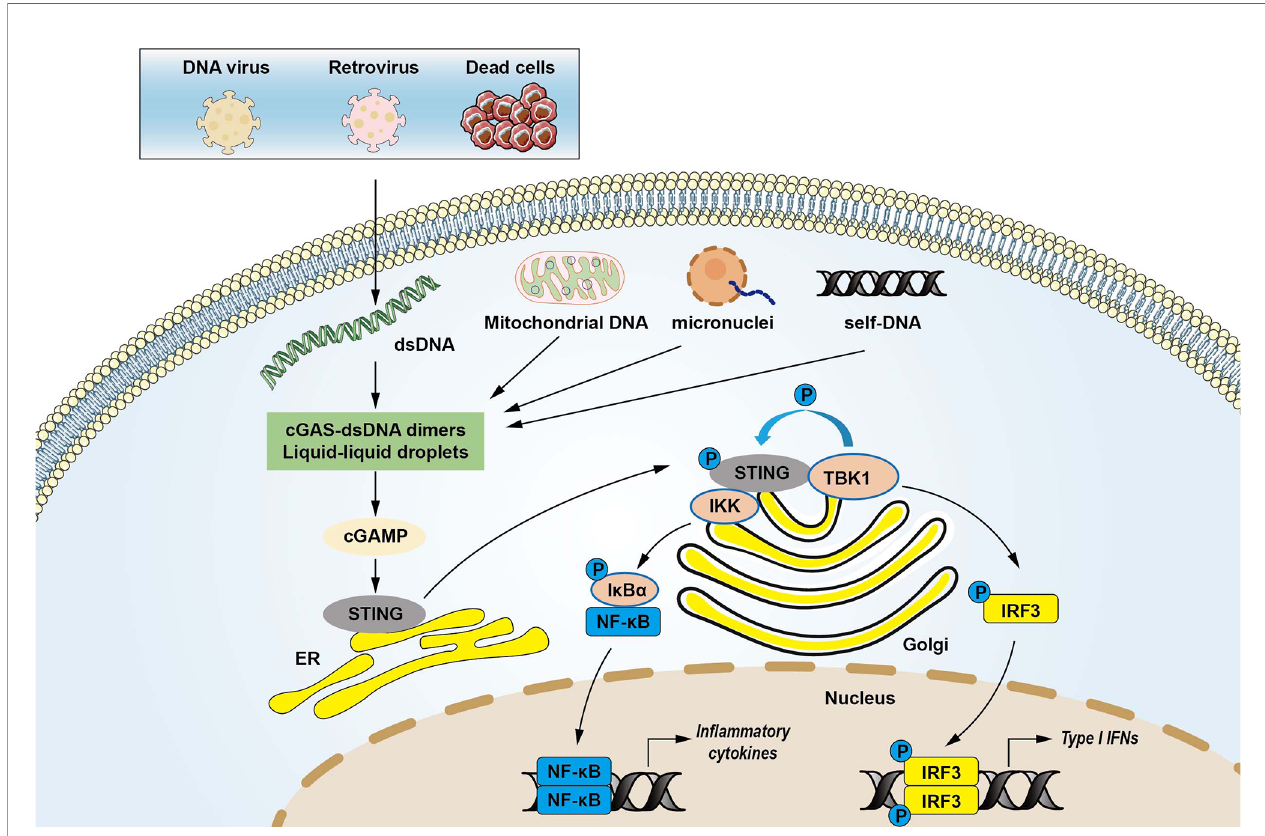
FIGURE 1 | The cytosolic DNA-sensing cGAS-STING pathway in innate immunity. Cyclic GMP-AMP synthase (cGAS) is a protein, which detects various cytosolic dsDNA, including viral DNA, damaged self-DNA released by dying cells, micronuclei, and mitochondrial origins. dsDNA activates cGAS via forming cGAS-dsDNA in 2:2 complexes. Mitochondrial damage and the release of mitochondrial DNA (mtDNA) in the cytosol also activates cGAS. The interactions of cGAS with DNA induce the formation of the liquid droplets through a phase transition, in which cGAS exerts its catalytic role to create the second messenger cGAMP that stimulates the stimulator of interferon genes (STING) at the endoplasmic reticulum (ER). STING then translocates from the ER to Golgi compartments and recruits kinases such as TANK-binding kinase 1 (TBK1) and I k B kinase (IKK), which in turn catalyzes the phosphorylation of IFN regulatory factor 3 (IRF3) and the nuclear factor- k B (NF- k B) inhibitor I k B a . Phosphorylated IRF3 translocates to the nucleus to activate transcription of genes encoding type I interferons and other in fl ammatory genes. I k B a phosphorylation accelerates nucleus translocation of NF- k B to promote transcription of target in fl ammatory cytokines, leading to activating in fl ammatory